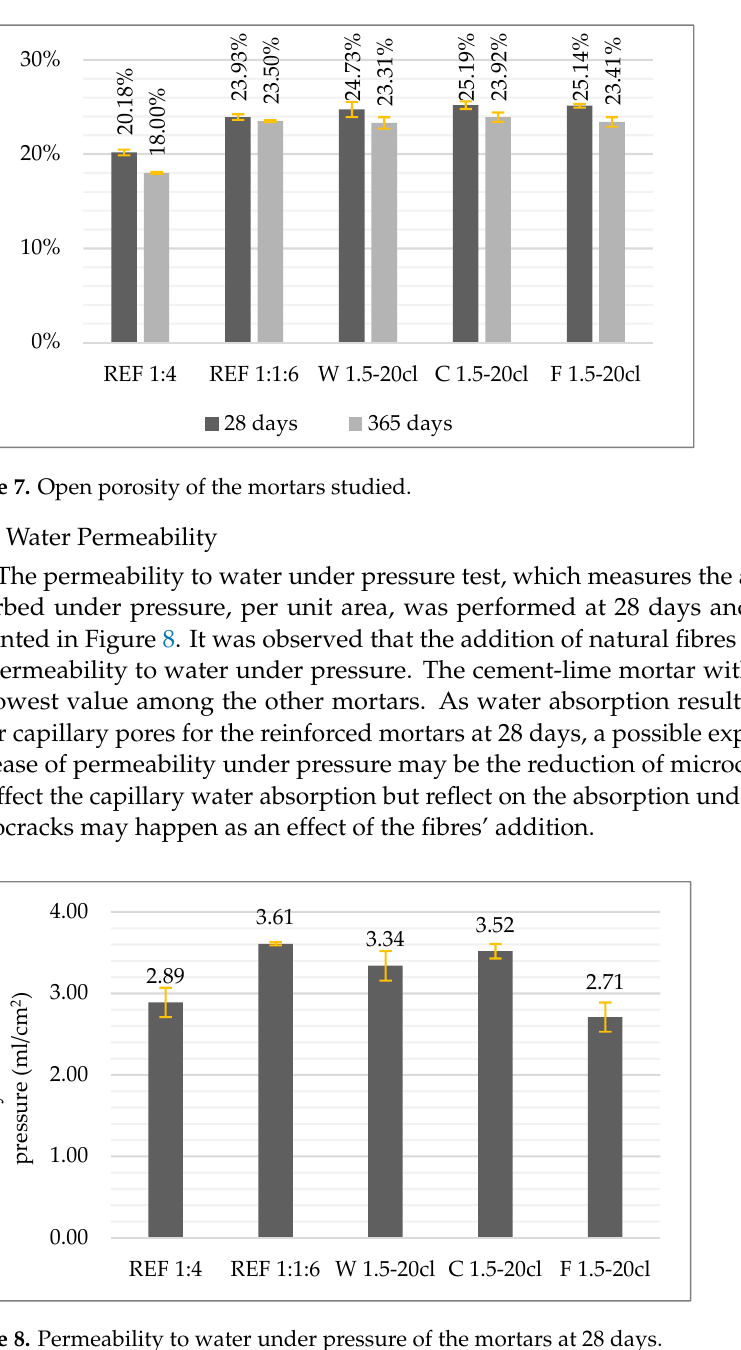
Figure 8. Permeability to water under pressure of the mortars at 28 days.